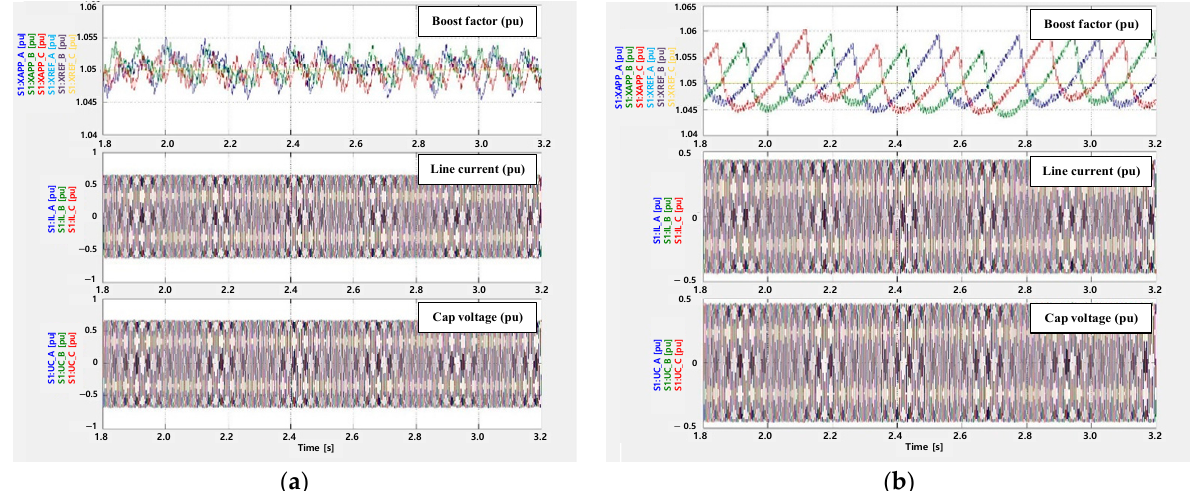
Figure 7. Results of the review of steady state operation before and after relocation. ( a ) Before relocation. ( b ) After relocation.